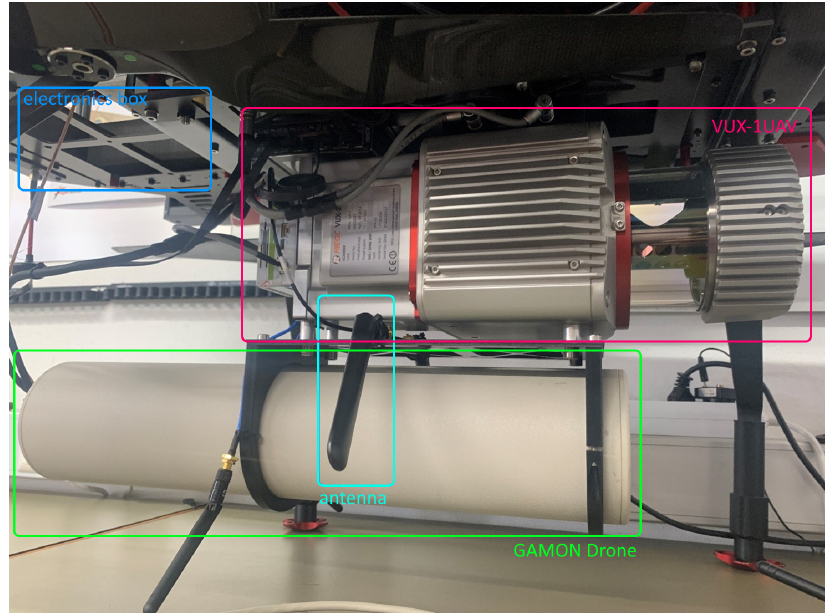
Figure 2. LiDAR sensor RIEGL VUX-1UAV (top, red) and CAEN Sys GAMON Drone gamma radiation spectroscopy system (green), electronics box (blue), antenna